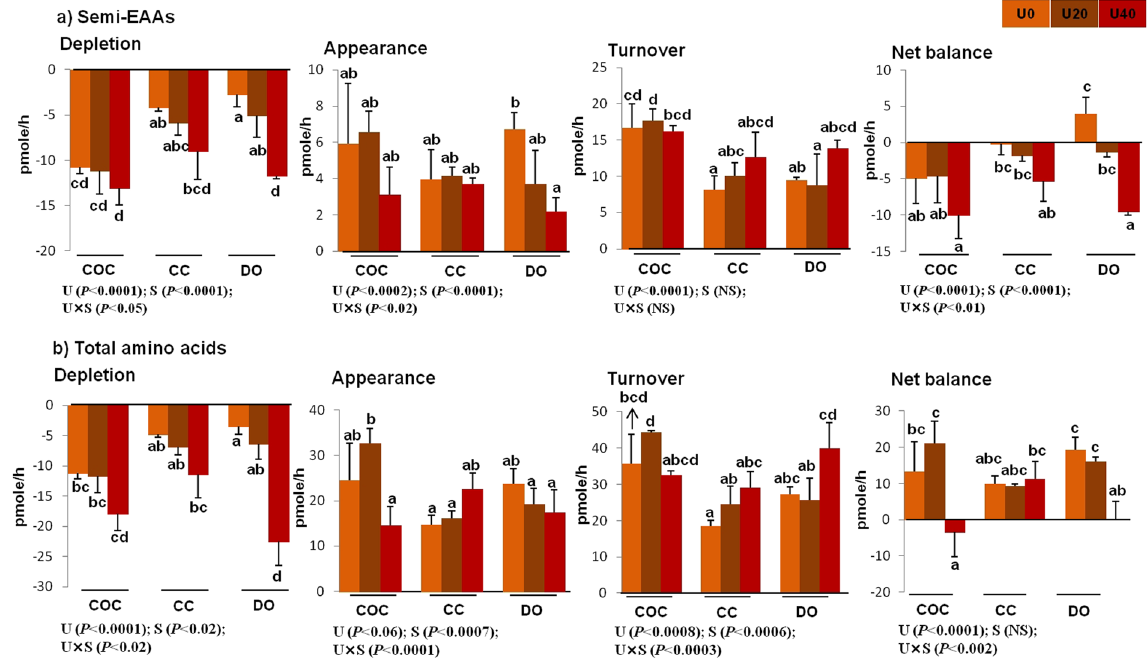
Figure 5. Total depletion, appearance, turnover, and net balance of semi-essential amino acids ( a ), as well as total amino acids ( b ), by bovine cumulus-oocyte complex, oocytectomized cumulus cells, or denuded oocytes in response to the presence of urea in maturation medium for 24 h. “Total depletion” or “total appearance” of amino acids means the sum of all negative or positive values obtained for non-essential amino acids. The “net balance” of amino acids was calculated by subtracting depletion from appearance, and the amino acid turnover was the sum of net depletion and appearance. U0: control (without urea); U20: 20 mg/dl urea; U40: 40 mg/dl urea. COC: cumulus-oocyte complex; CC: cumulus cells; DO: denuded oocytes; U: the main effect of urea; S: the main effect of specimens (cell type: COCs, DOs, and CCs); U × S: interaction between urea and cell type. Data are presented as least squares means (LSM) ± standard error mean (SEM) indicated by two-way ANOVA over PROC GLM. Different letters (a, b, c, etc.) indicate significant differences between the treatments at P < 0.05. NS: non-significant.